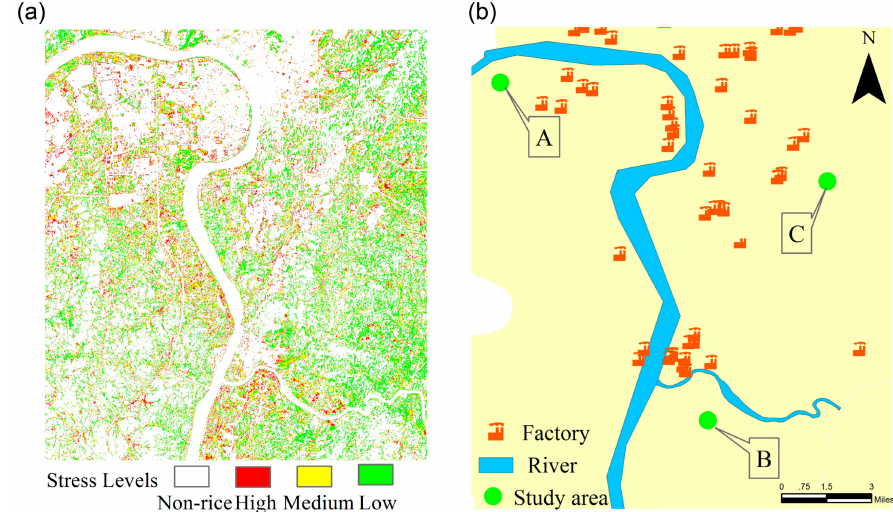
Figure 7. ( a ) Spatial distributions of stress levels using the multitemporal monitoring model at whole growth stage; ( b ) Spatial distributions of factories in the region.